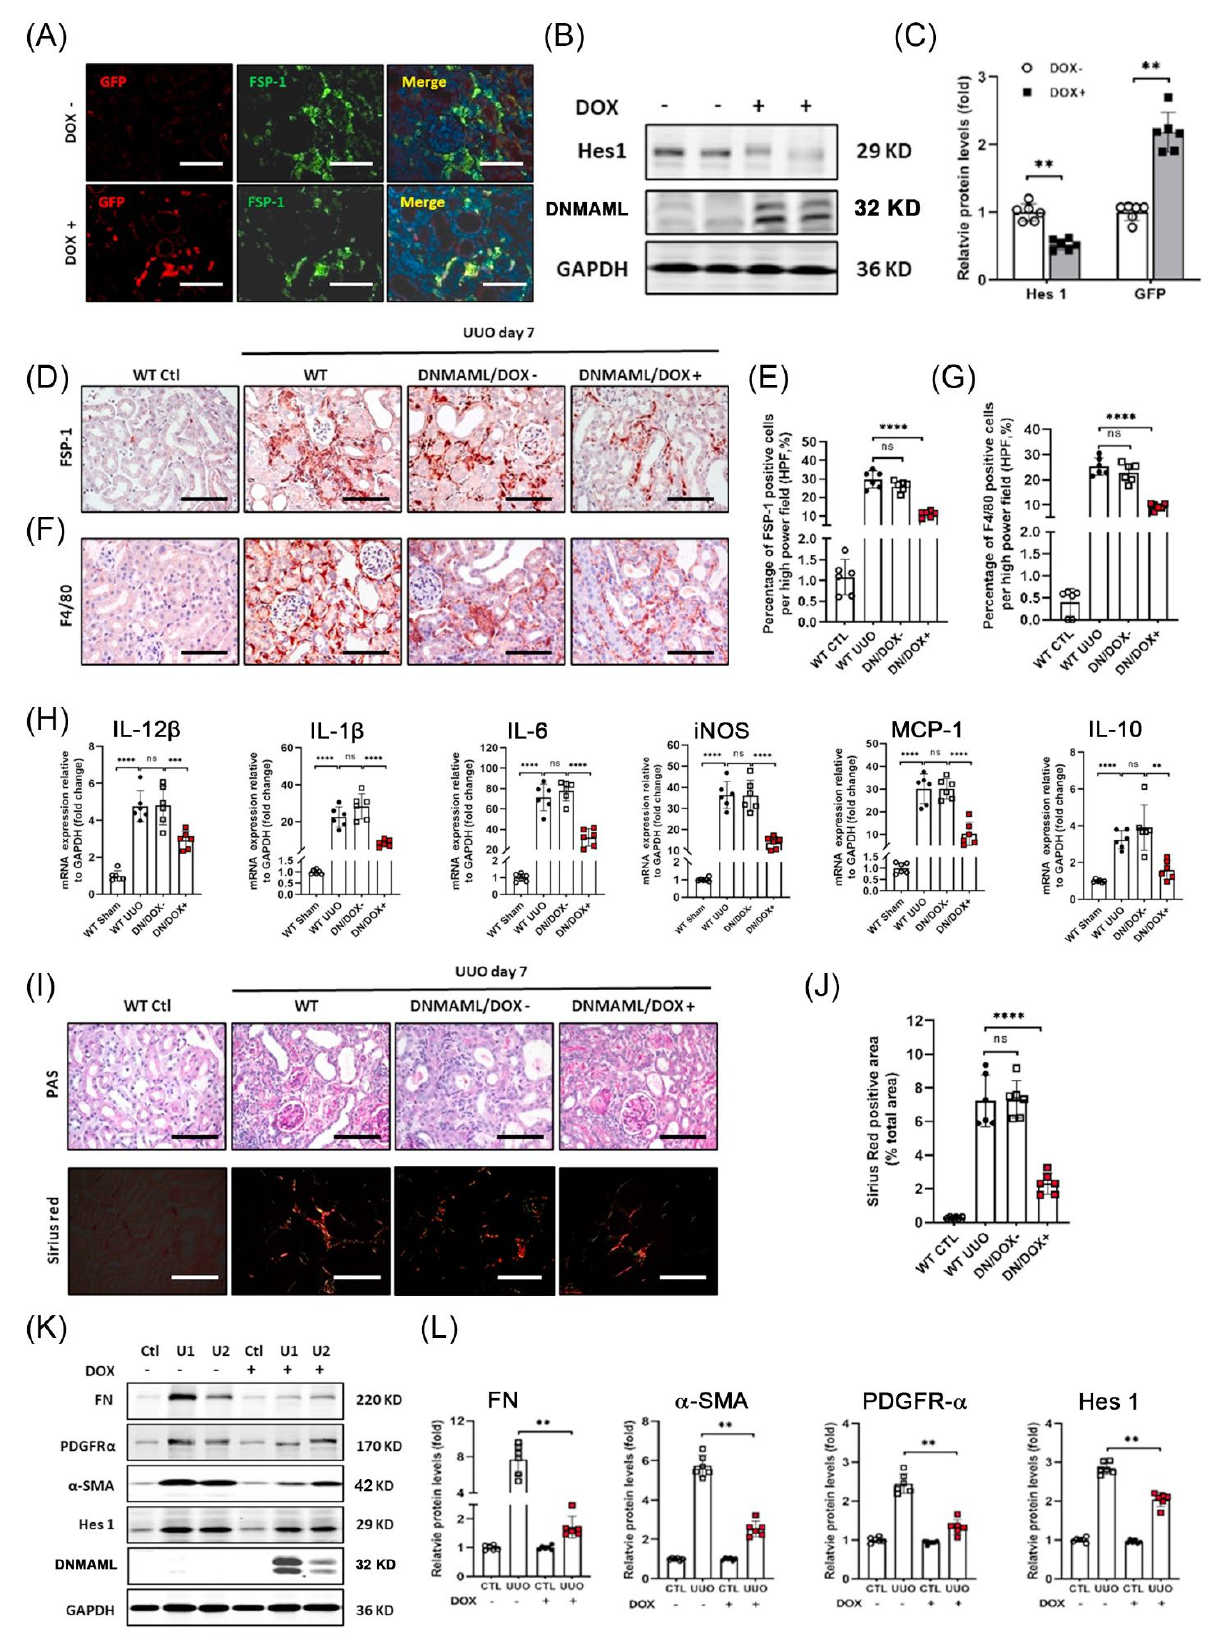
Figure 7. DNMAML overexpression-mediated specific Notch blockade in FSP-1 + cells inhibits renal inflammation and fibrosis. ( A ). Double fluorescent immunostaining of FSP-1/GFP in ob-structed kidneys of mice with or without Dox induction. ( B , C ). Western blot and density analysis of